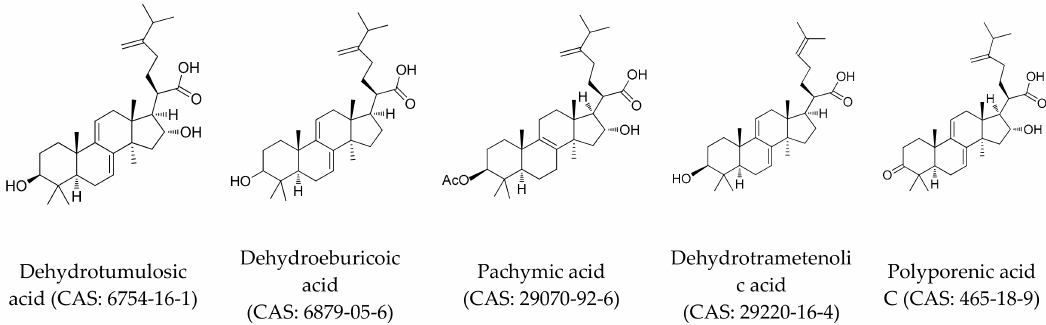
Figure 4. The structures of dehydrotumulosic acid, dehydroeburicoic acid, pachymic acid, dehydrotrametenolic acid, and polyporenic acid